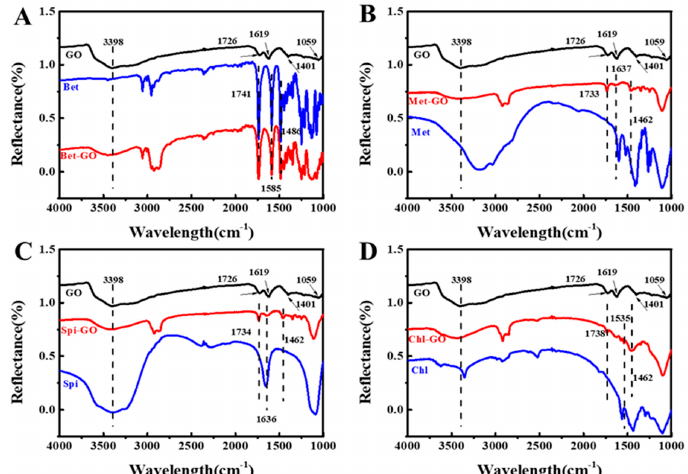
Figure 5. FT-IR spectra of Bet-GO at (1:9) ( A ), Met-GO at 3:7 ( B ), Chl-GO at 5:5 ( C ), Spi-GO at 3:7 ( D ) characterization of GO, pesticide and pesticide-GO.